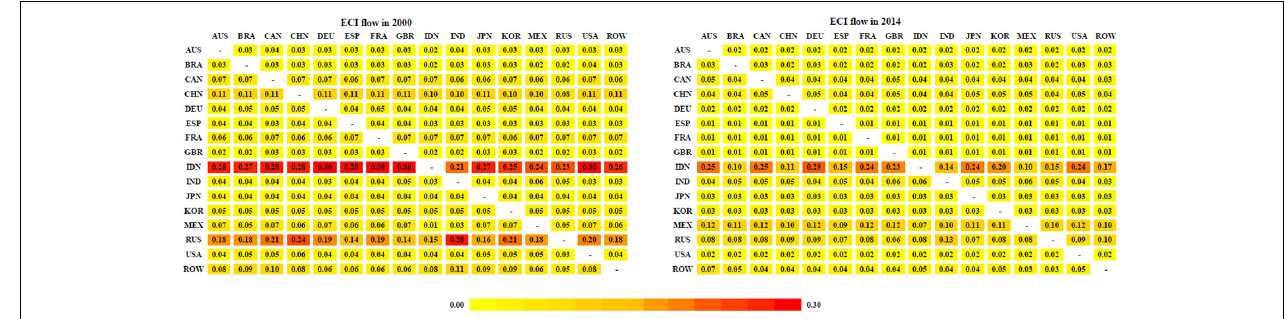
FIGURE 3 | Information and communication technologies embodied carbon intensities among major countries in 2000 and 2014. Note: EC represents the embodied carbon emissions, ECI represents the embodied carbon emission intensities.